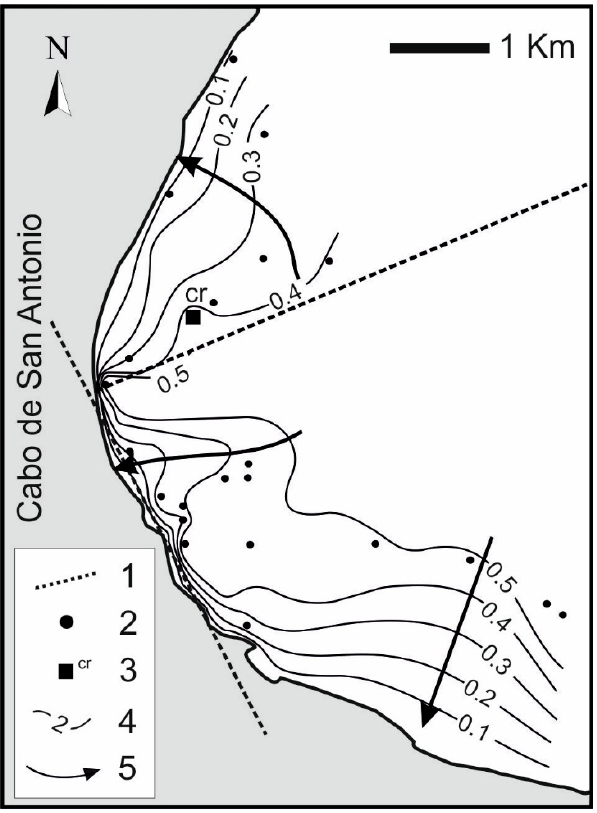
Figure 3. Groundwater pathway in site 2 in Figure 1. Legend: 1. main fault; 2. well; 3. karst cave; 4. potentiometric contour line and hydraulic head in m.a.s.l.; 5. main groundwater flow direction.